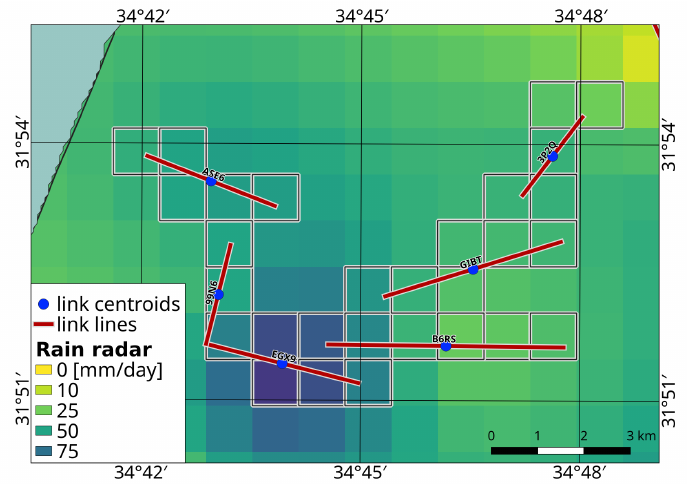
Figure 3. Zoomed image of weather radar over the northern part of Israel. Radar image values are summed for all pixels intersected by each link line. This sum of radar rainfall is assumed to be located at the link centroid for kriging